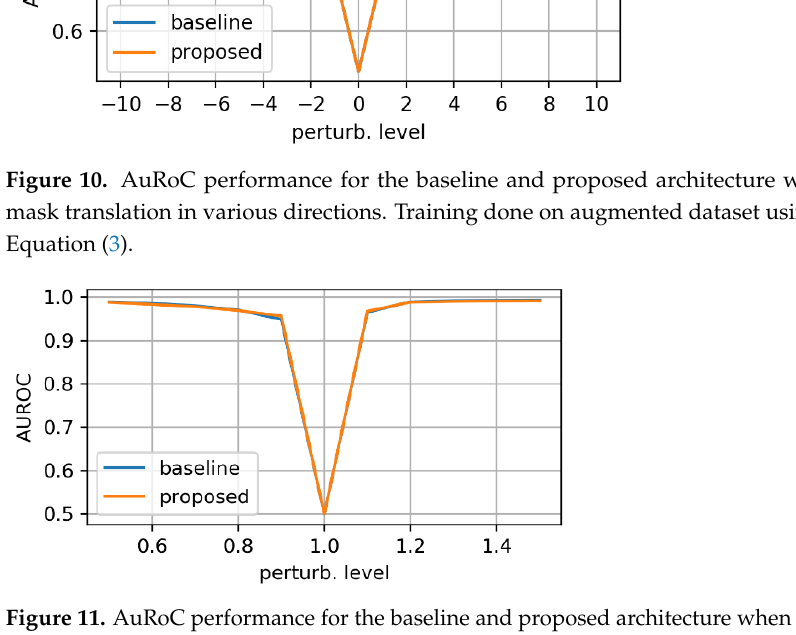
Figure 11. AuRoC performance for the baseline and proposed architecture when tested against mask zooming. Training done on augmented dataset using the hinge loss in Equation